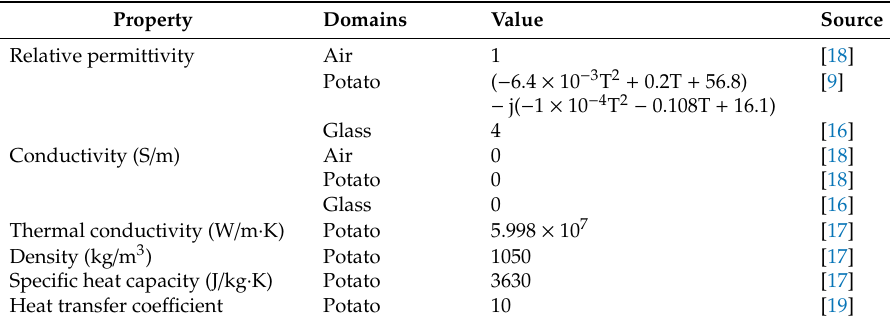
Table 1. Input parameters used in the simulations.